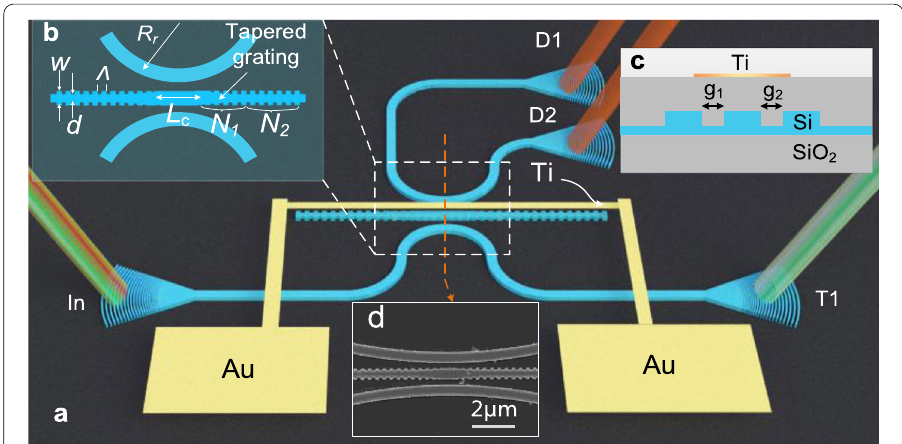
Fig. 1 Design of the FSR-free ADF. a Schematic 3D view of the ADF based on three coupled waveguides with a central grating-assisted F-P cavity. b Top view of the filter consisting of Bragg grating mirrors, tapered grating, and point-defects cavity, indicated within the dashed white rectangle in a . c Cross-section of the coupling region of the filter, indicated by the dashed orange line in a . d Top-view SEM image of the